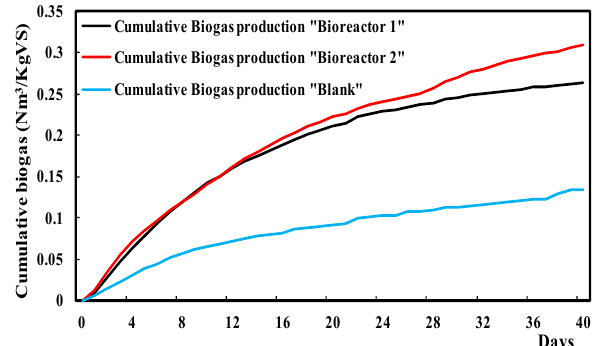
Figure 2. Daily biogas production of the three bioreactors.